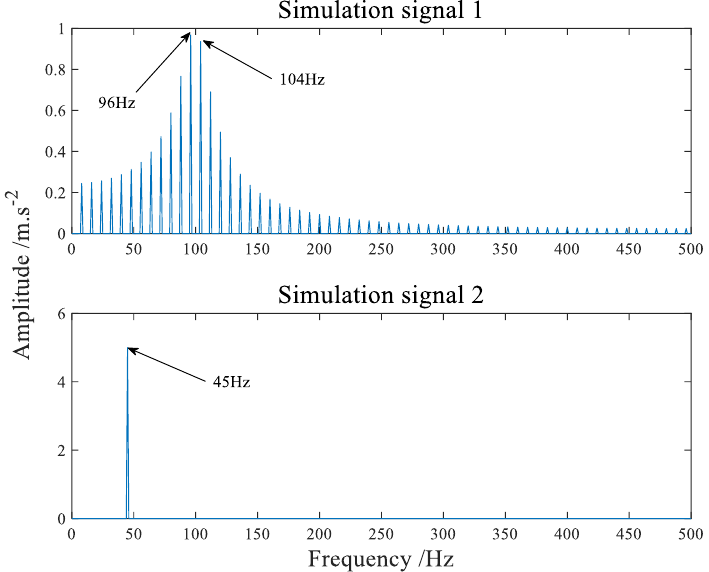
Figure 5. The amplitude spectrum of simulation signals.